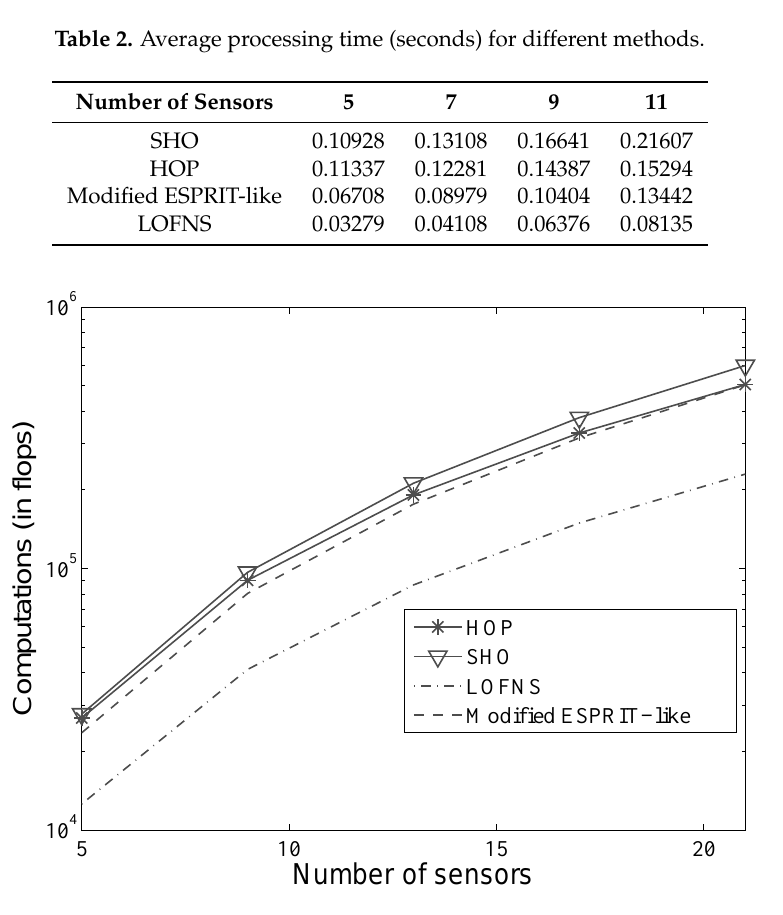
Figure 2. Flops versus number of